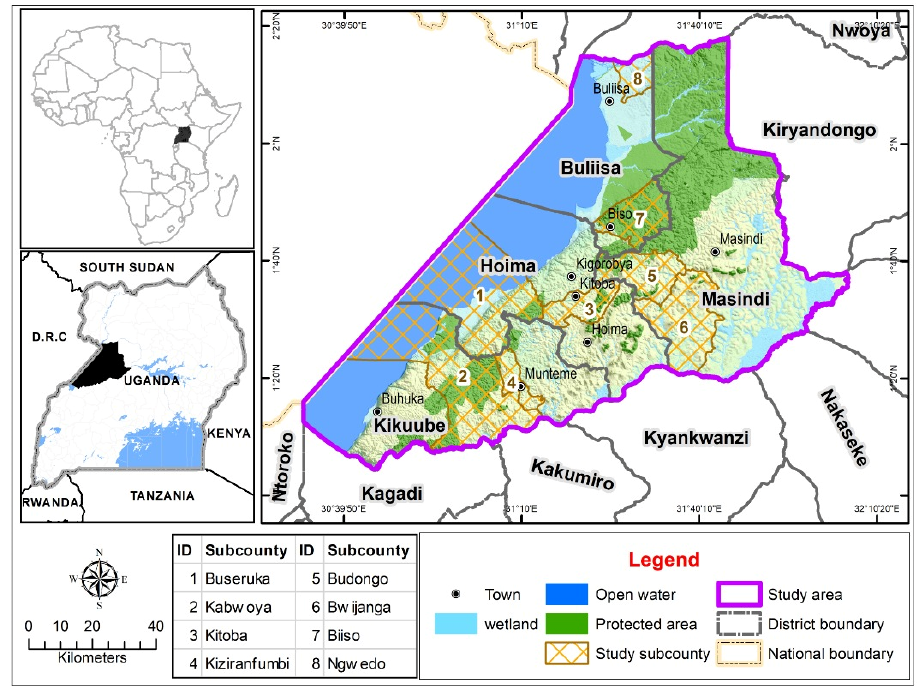
Figure 1. Map showing location of Budongo–Bugoma landscape in Mid-Western Uganda .